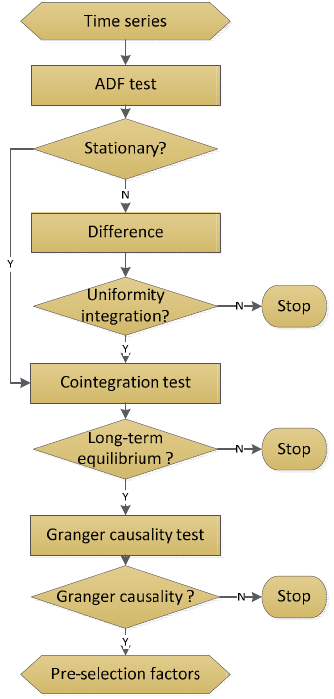
Figure 6. The flowchart of external factor selection